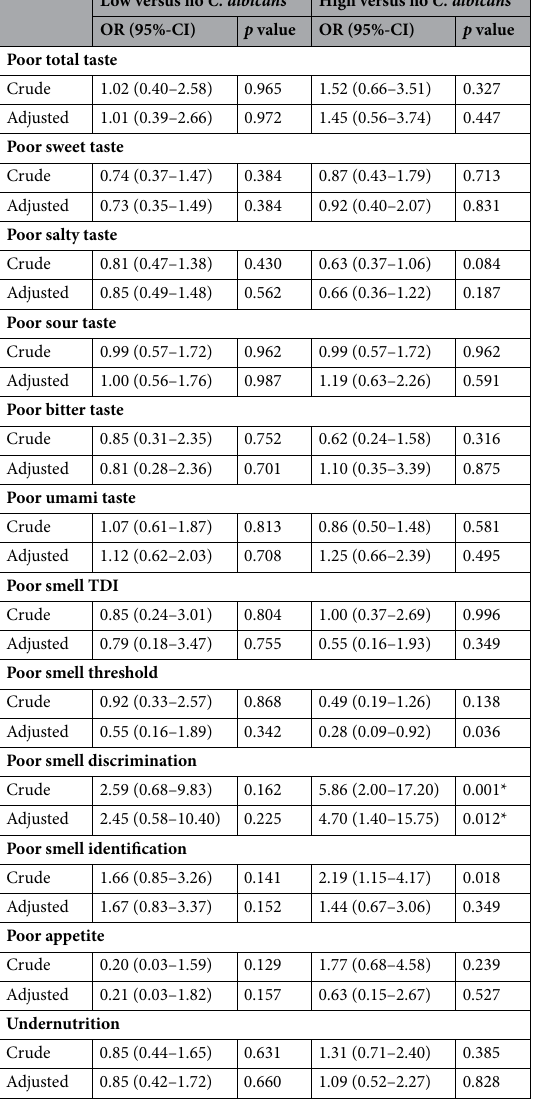
Table 1. Logistic regression of low or high Candida albicans abundance versus no C. albicans with poor taste, smell, appetite, and undernutrition. Shown are odds ratio (OR), 95% confidence interval (95%-CI), and uncorrected p values. Asterisks indicate statistical significance ( p < 0.008 for poor taste; p < 0.013 for poor smell (Bonferroni corrected); or p < 0.05 for poor appetite or undernutrition). Adjusted models include covariates: age, dentition, sex, educational status, smoking status, medication use, CESD-score, MMSE-score. Poor taste: total taste score < 6, sweet score < 2, sour score < 2, salty score < 2, bitter score < 1, umami score < 1. Poor smell: TDI-score ≤ 19.5, T-score ≤ 2.5, D-score ≤ 7, I-score ≤ 9. Poor appetite: Council of Nutrition Appetite Questionnaire score < 28. Undernutrition: > 5% bodyweight loss averaged over 2 years or BMI < 20 (if age < 70) or BMI < 22 (if age > 70) or